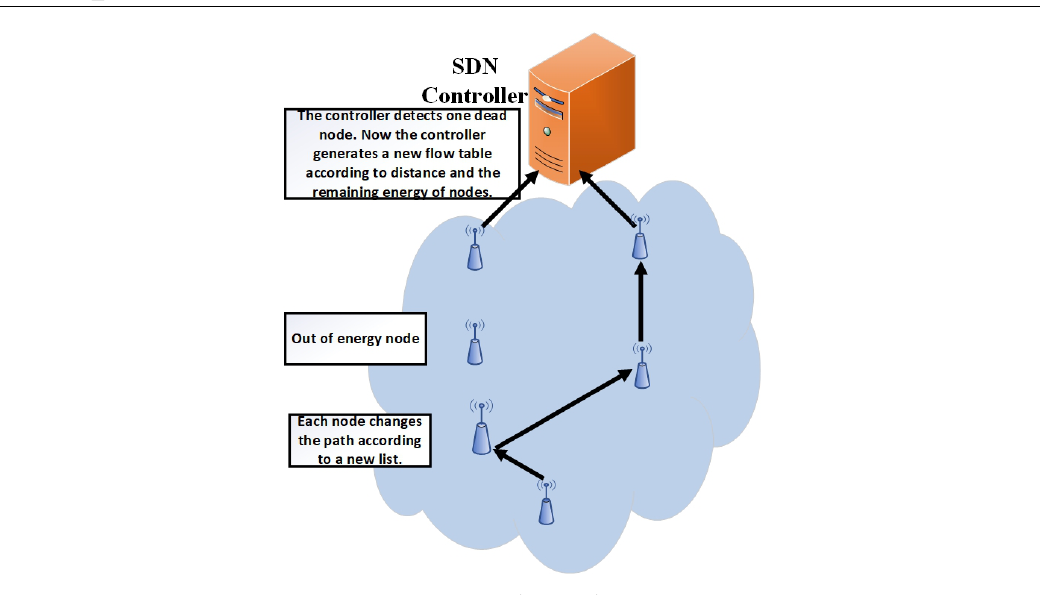
Figure 8. Updating phase